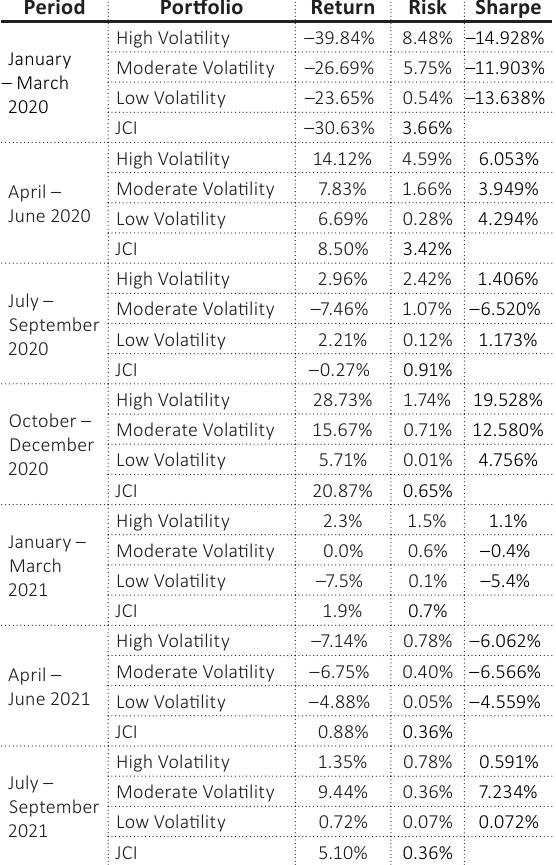
Table 1. Portfolio smart beta 2020–2021